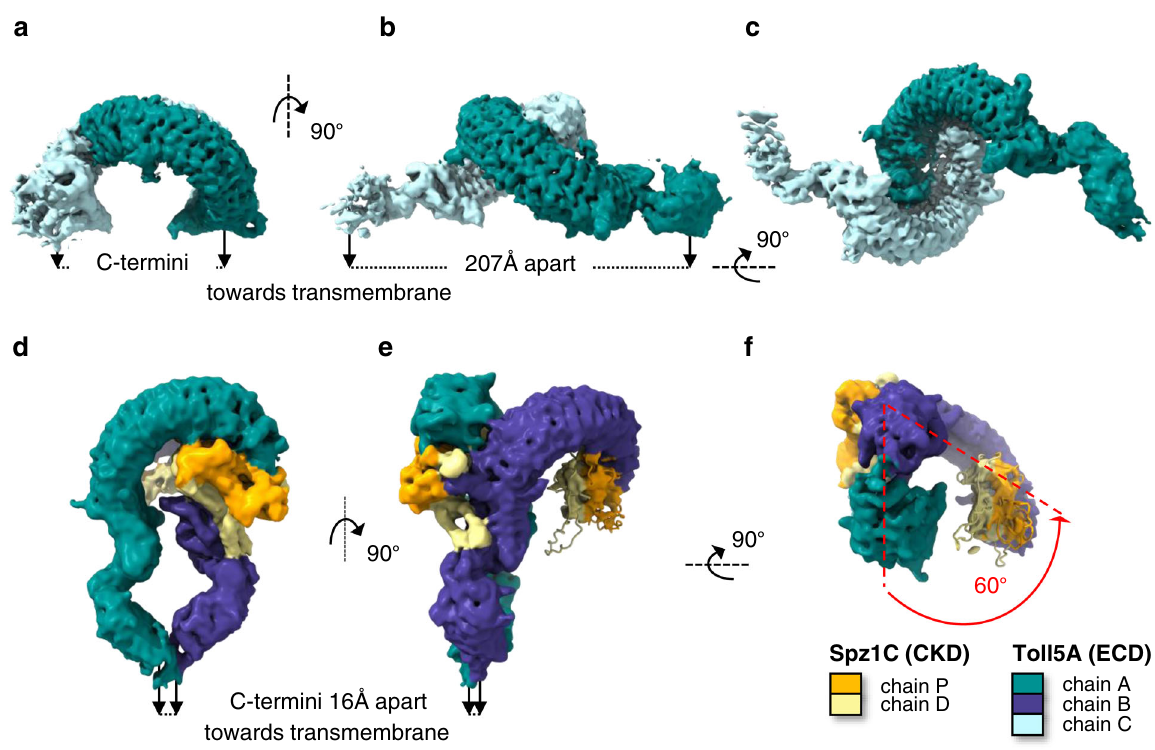
Fig. 1 | Cryo-EM structures of Toll5A homodimer and Spz1C-ligated hetero- dimer. Orthogonal and bottom-up views of cryo-EM density maps. Density is colour-codedaccordingtoproteincontent. a – c Toll5Ahomodimerviewedinthree different orientations. d – f Spz1C-bound heterodimer. f View from the membrane